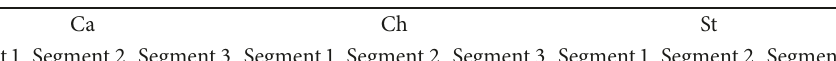
Table 3: Kappa values of interrater reliability.